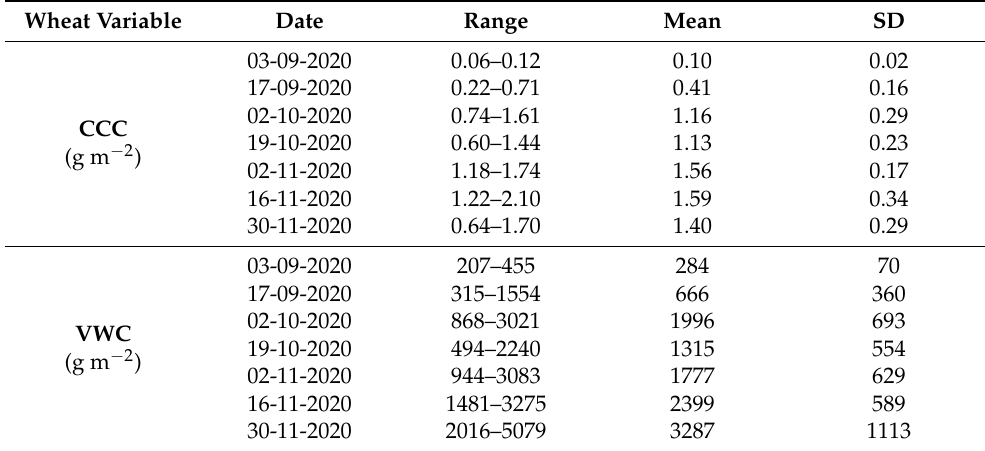
Table 3. Dates, ranges, mean values, and standard deviations (SD) for calculated variables (CCC and VWC).